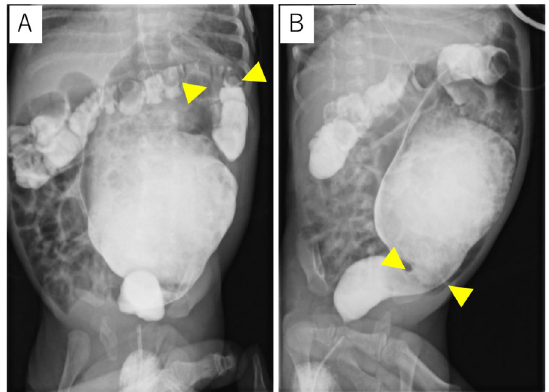
Fig. 2 The contrast enema on Day 41. The constant enema showed localized intestinal dilatation from the descending colon to the sigmoid colon with abrupt caliber changes (arrowheads) in the oral and anal sides of the dilated colon. A Spine position and B left lateral